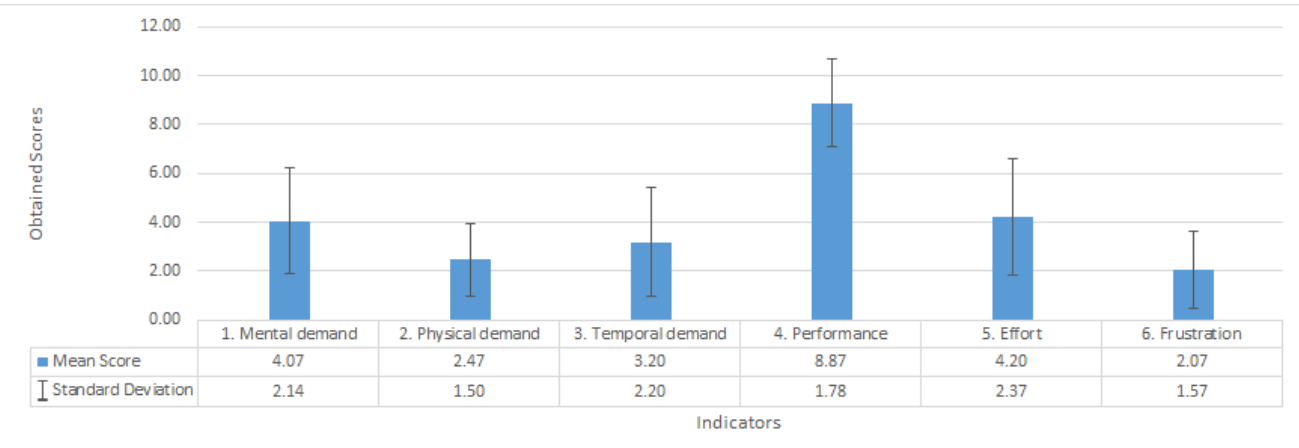
Figure 6. Workload assessment scores for NASA-TLX test question